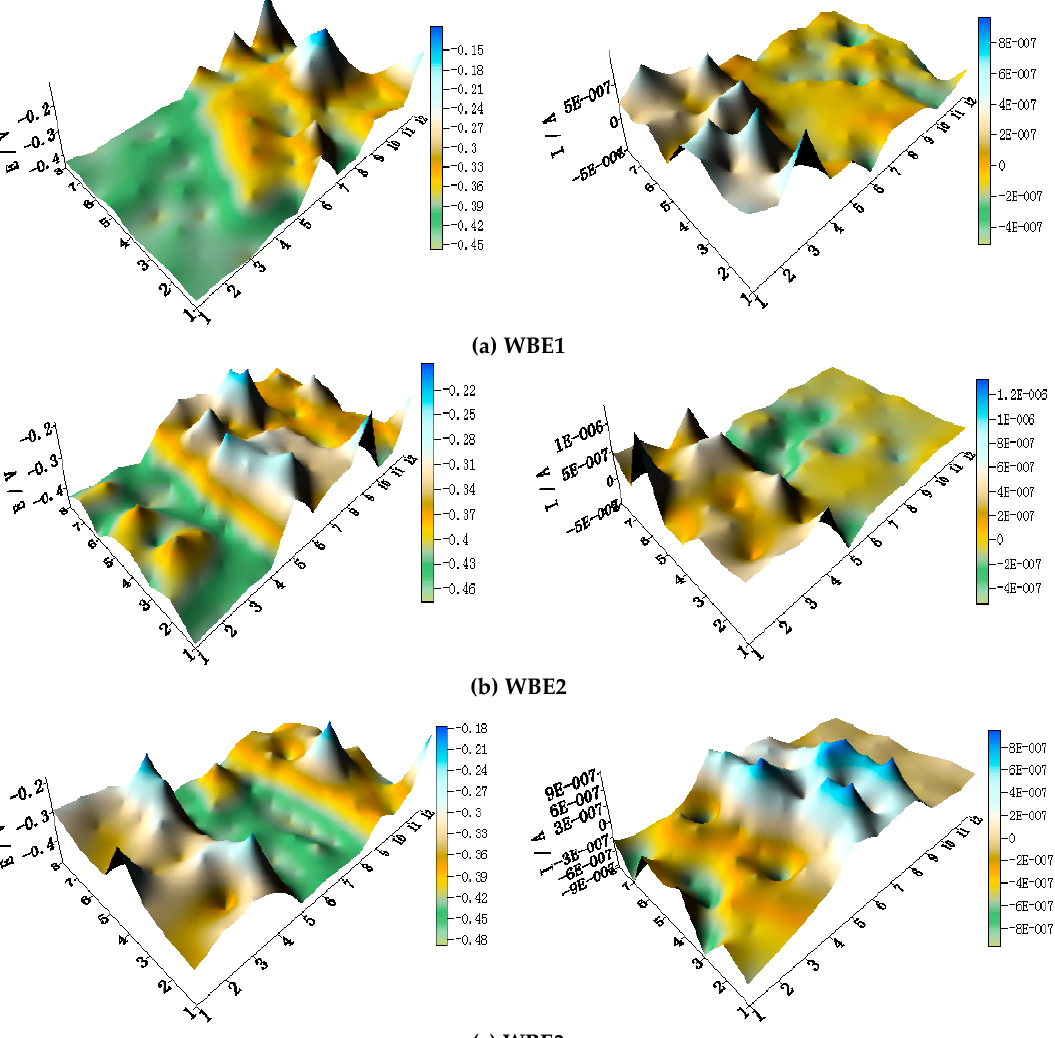
Figure 21. Spatial potential (left, E vs. SCE/V) and current–density (right, I/A) distribution maps of three electrodes after being short-circuited for 12 h in artificial seawater with 2.7 wt % Cl − at 70 °C: ( a ) WBE1, HAl77-2/316L SS/TA2; ( b ) WBE2, HAl-77-2/TA2/316L SS; and ( c ) WBE3, TA2/HAl77-2/316L SS.